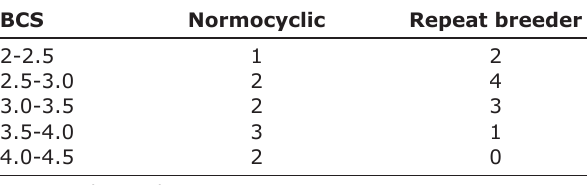
Table-4: BCS of normocyclic and repeat breeder